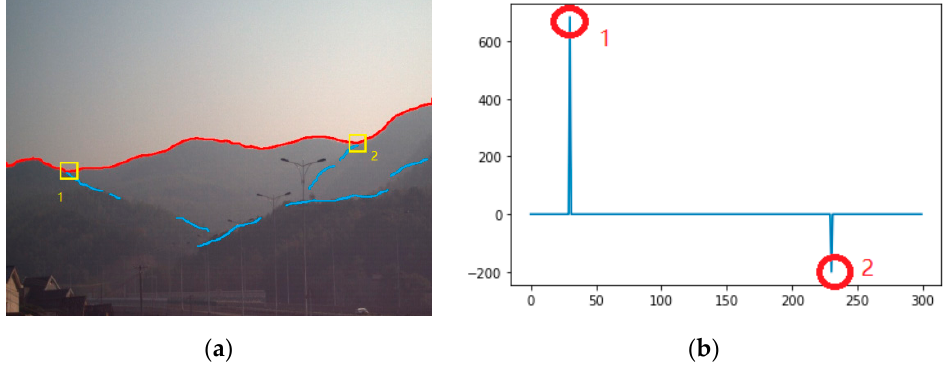
Figure 23. The candidate locations were verified by the feature of lapel points. The retrieved image contains two lapels points ( a ), and the DEM candidate point also contain two similar lapel points at the position where the skyline coincides ( b ). This improves the reliability of the location where the image was